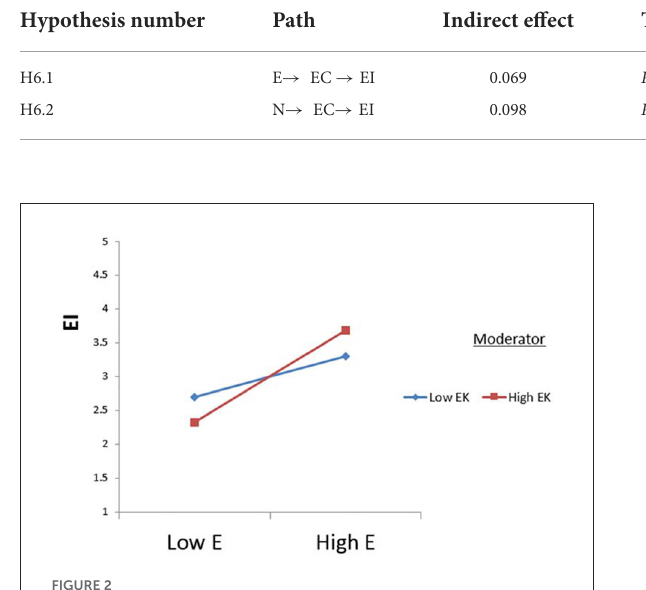
FIGURE2 Moderating effect of environmental knowledge (EK) on the relationship between extraversion (E) and ecotourism intention (EI).